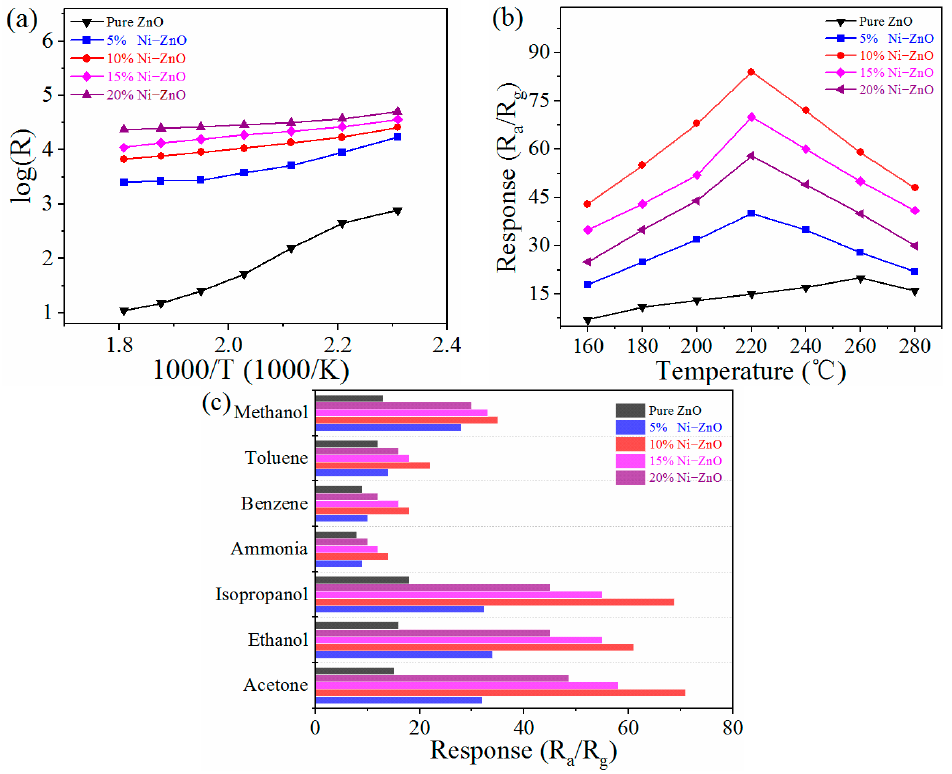
Figure 6. ( a ) Resistance of the ZnO-based sensors in air at various working temperatures. ( b ) Responses of ZnO-based sensors upon exposure to 100 ppm formaldehyde vapor at different working temperatures. ( c ) Responses of ZnO-based sensors upon exposure to different gases (100 ppm) at their optimal temperatures.